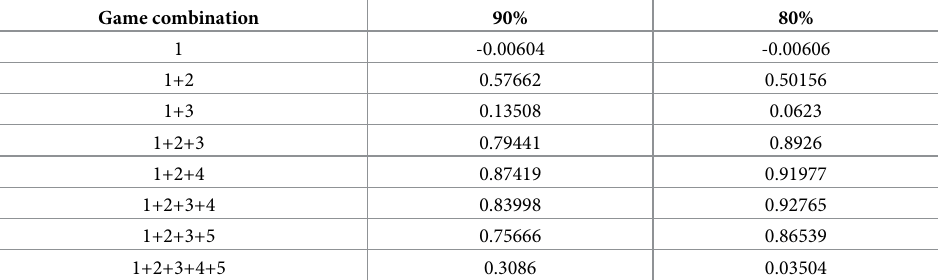
Table 8. Benefit growth of two allocation modes in China and other countries under different game combinations and water